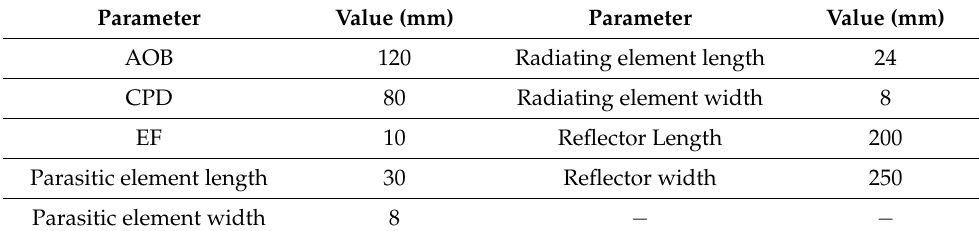
Table 1. Design dimensions of the proposed Kirigami MIMO antenna. Parameter Value (mm) Parameter Value (mm) AOB 120 Radiating element length 24 CPD 80 Radiating element width 8 EF 10 Reflector Length 200 Parasitic element length 30 Reflector width 250 Parasitic element width